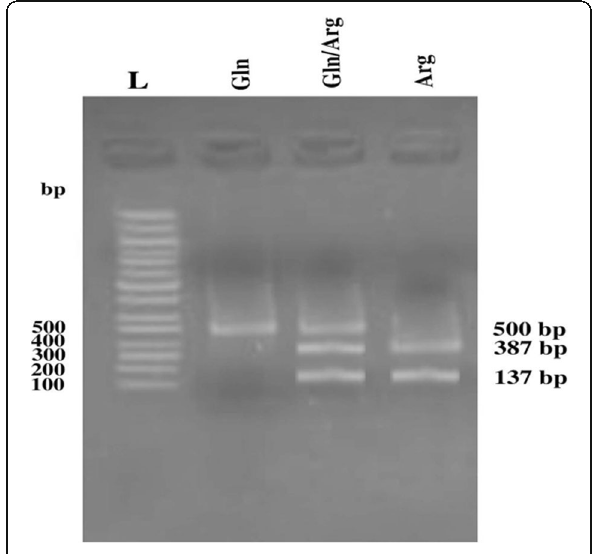
Fig. 1 The XRCC1 399 Gln allele was not cleaved, whereas the XRCC1 399 Arg allele was cleaved into 387-bp and 137-bp fragments